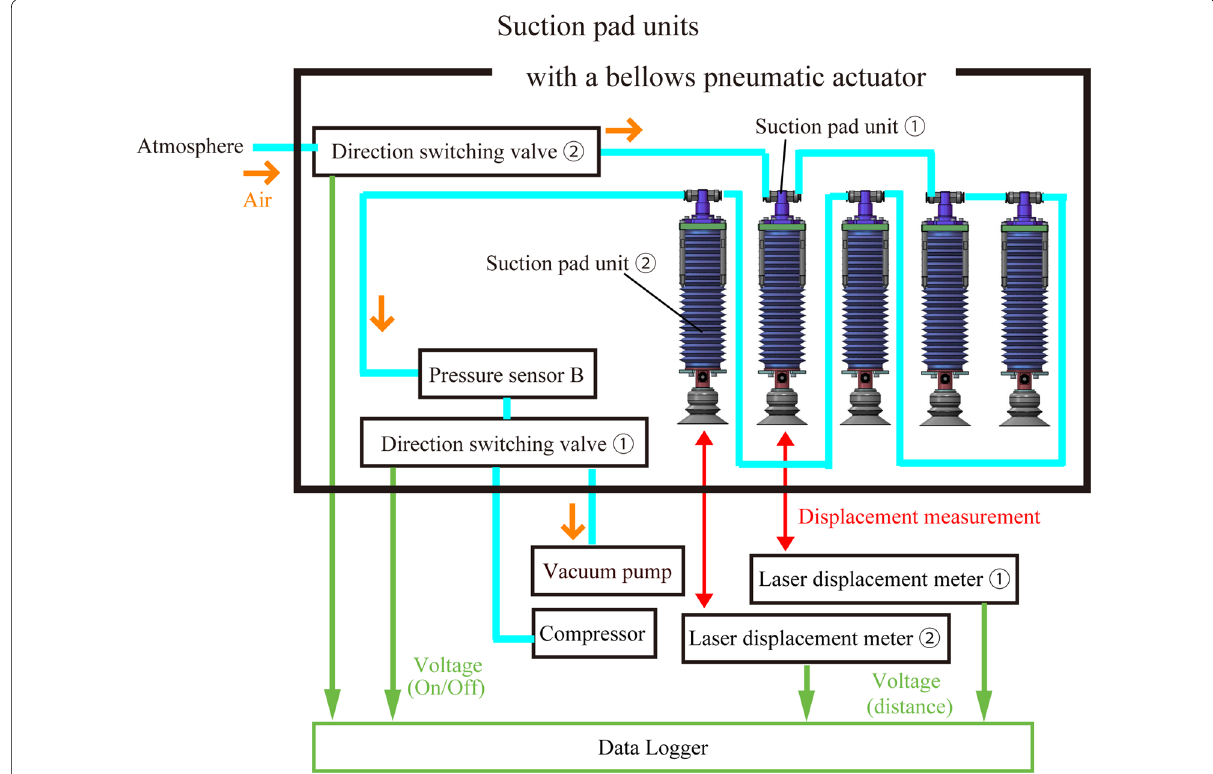
Fig. 26 Configuration of the expansion and contraction motion evaluation experiment system